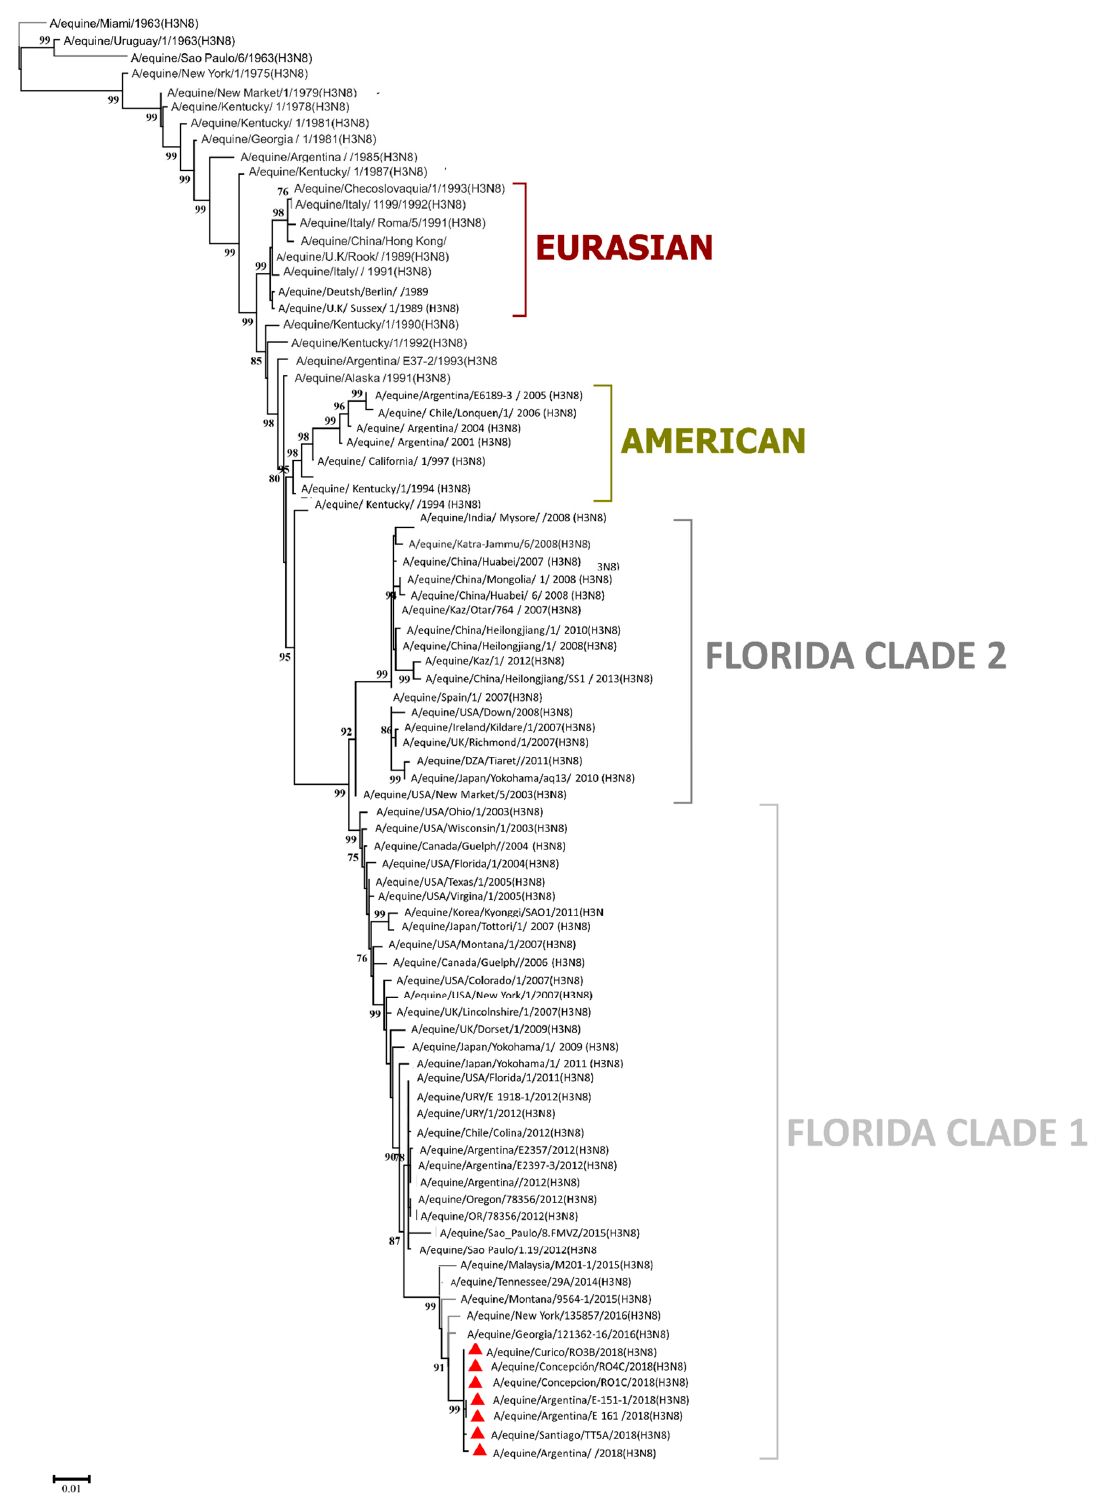
Figure 3. Maximum credibility for the complete HA gene of H3N8 EIV. Phylogenetic analysis of hemagglutinin (HA) gene nucleotide sequences from 86 equine influenza viruses (EIVs). The maximum likelihood tree was constructed using the stringent GTR + G algorithm, which was identified by using the best DNA/protein model tool available in MEGA 7. The reliability of the trees was assessed by bootstrapping with 1000 replications. Clades: Eurasian, American, Florida clade 1, and Florida clade 2. Red triangles denote samples belonging to the 2018 South American